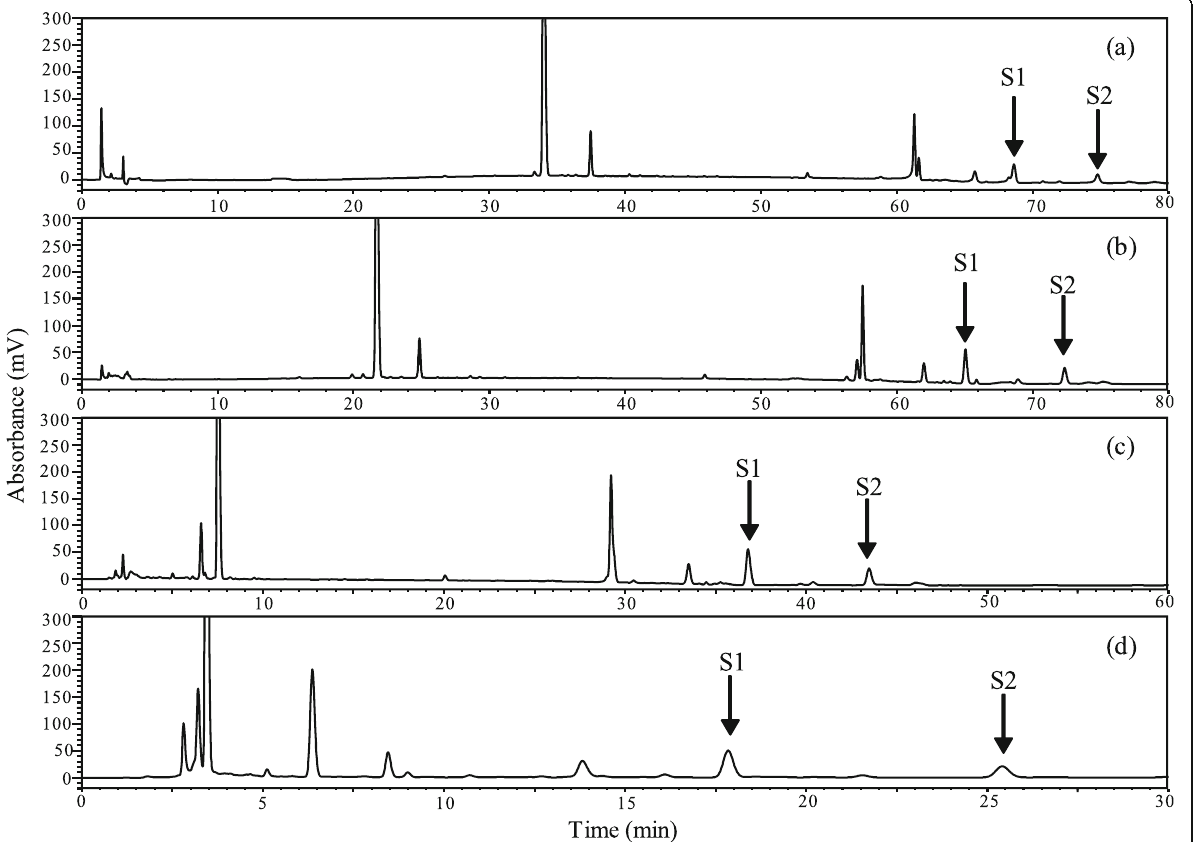
Fig. 2 HPLC chromatograms of Inonotus obliquus under different elution conditions: ( a ) 5% B at 0 min, 99% B at 60 min, 99% B at 80 min; ( b ) 30% B at 0 min, 99% B at 60 min, 99% B at 80 min; ( c ) 60% B at 0 min, 99% B at 30 min, 99% B at 60 min, ( d ) 95% B for 30 min. S1: inotodiol; S2: 3 β - hydroxylanosta-8,24-dien-21-al. HPLC conditions: column, HECTOR-M C 18 (250 × 4.6 mm, 5 μ m); flow rate, 1 mL/min; injection volume, 10 μ